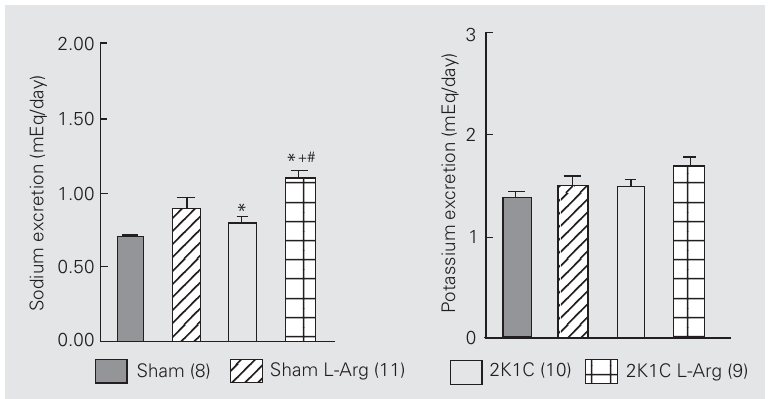
Figure 4. Urinary sodium and potassium excretion of sham-operated and two-kidney, one- clip (2K1C) rats treated or not with oral L-arginine (L-Arg). The data are shown for 7 days of L-Arg administration. Data are reported as means ± SEM. The number of animals in each group is given in parentheses. *P<0.01 compared with sham; + P<0.01 compared with sham L-Arg; # P<0.01 compared with 2K1C (Tukey test).